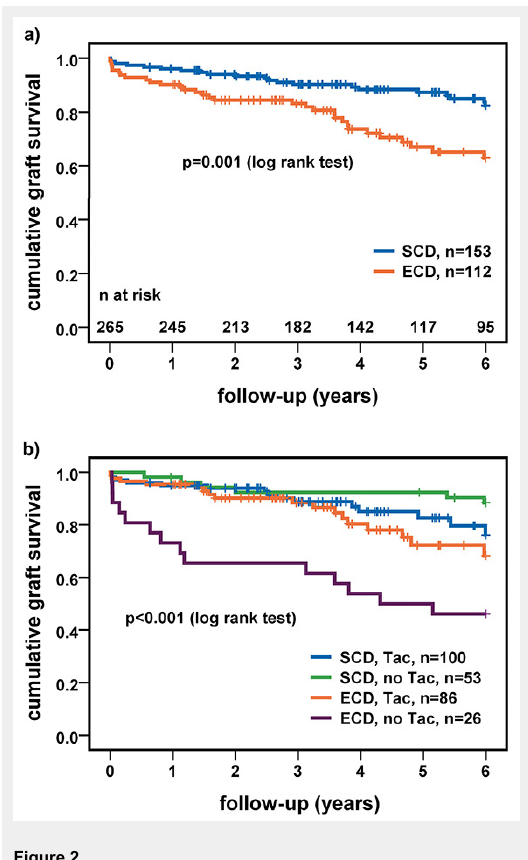
Figure 2 (a) Cumulative graft survival stratified by donor status. (b) Cumulative graft survival stratified by donor status and immunosuppression; p-values of difference between subgroups in figure 2b: ECD/Tac versus ECD/no Tac p = 0.008 (log rank test); SCD/Tac versus SCD/no Tac p = 0.1 (log rank test). ECD = expanded-criteria donor; SCD = standard-criteria donor; Tac = tacrolimus